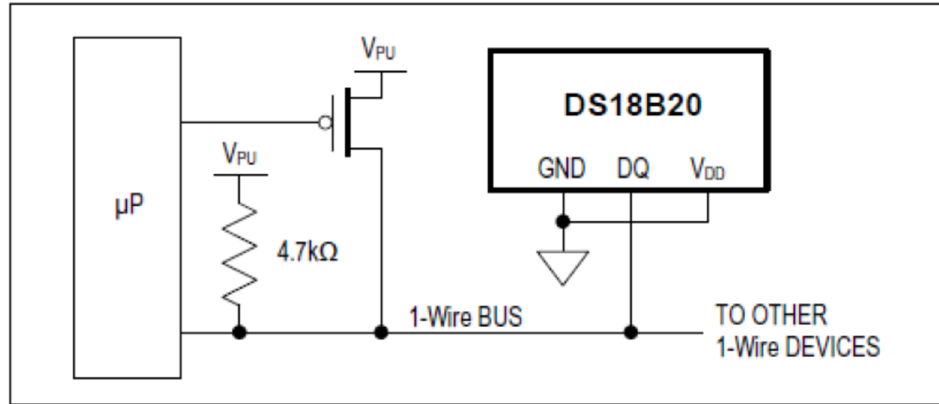
Figure 8. Parasite power connection graphic representation [60].